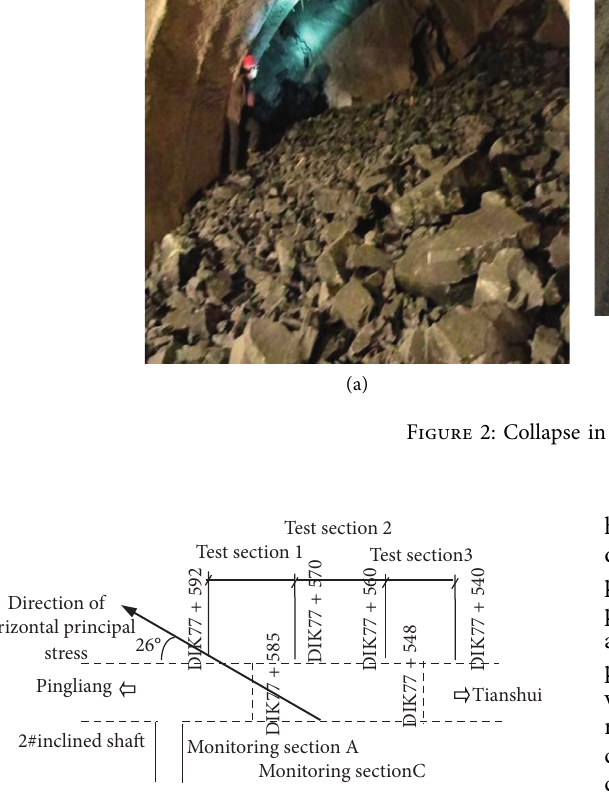
Figure 3: Positions of three test sections.